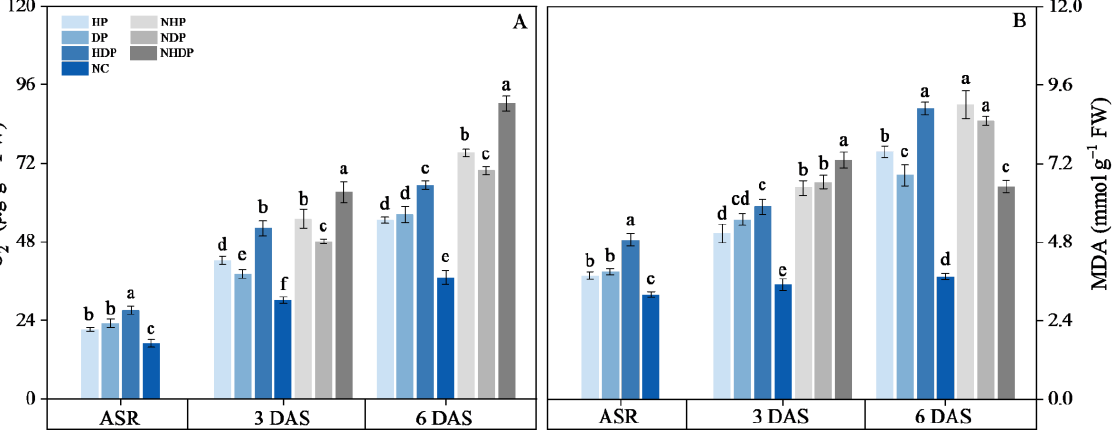
Figure 5. Effects of stress priming on superoxide anion (O 2 − , A ) and malondialdehyde (MDA, B ) contents of seedlings under stress conditions. HP, heat priming + later heat stress; DP, drought priming + later drought stress; HDP, combined stress priming + later combined stress; NHP, no heat priming + later heat stress; NDP, no drought priming + later drought stress; NHDP, no combined stress priming + later combined stress; NC, no stress priming + no later stress. The bars represent the ± SDs (n = 5), where different letters designate significant differences at the 0.05 level.